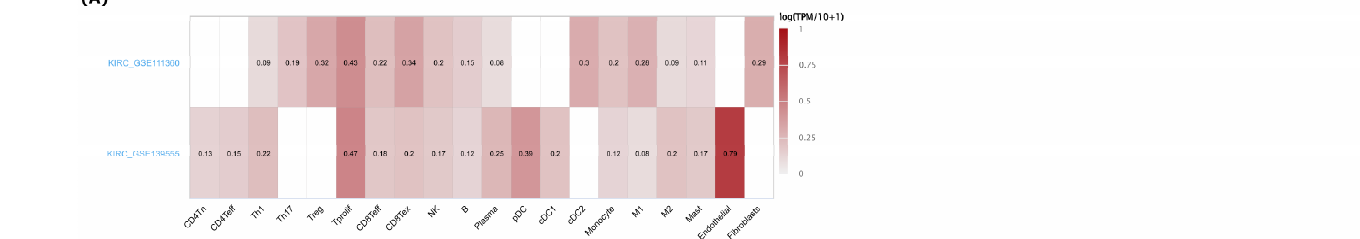
Figure 9. Expression of GOT2 in scRNA-seq landscapes. ( A ) Heatmap of GOT2 expression displayed heterogeneity in different clusters of cells in KIRC_GSE111360 [55] and KIRC_GSE139555 datasets [56]. ( B ) Expression of GOT2 in GSE111360 (upper panel) and in GSE139555 (lower panel) datasets after Uniform Manifold Approximation and Projection (UMAP) processing. Violin diagrams depict the GOT2 expression in different immune cells across each dataset analyzed. Figure 10. The expression source of the signature genes was revealed by single-cell analysis (GSE111360 dataset). The signature was composed of GOT2 , LAG3 , CTLA4 , EOMES , LGALS9 , CD96 , HAVCR2 , PDCD1 , TIGIT , and TOX .